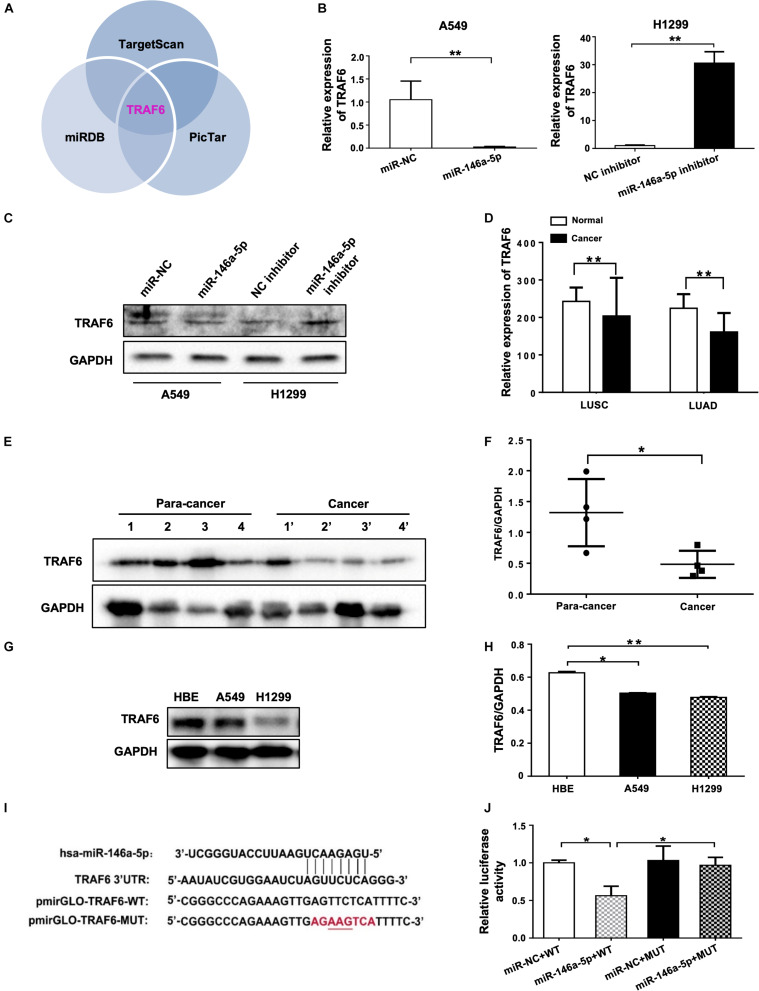
miR-146a-5p directly targets TRAF6 in NSCLC Cells. (A) TRAF6 is one of miR-146a-5p targets predicted by TargetScan, miRDB and PicTar databases. Expression of TRAF6 mRNA (B) and protein (C) in A549 cells or H1299 cells at 24 h transfection with miR-146a-5p mimic, or miR-146a-5p inhibitor respectively. (D) Expression of TRAF6 from TCGA, LUSC: lung squamous cell carcinoma, LUAD: lung adenocarcinoma. (E) Differential TRAF6 protein levels in NSCLC tissues and the paired adjacent normal tissues. (F) Quantitation of WB data as in (E). (G) TRAF6 levels in two NSCLC cell lines and HBE cell line. (H) Quantitation of WB data as in (G). (I) miR-146a-5p binding site within the 3’UTR of human TRAF6 mRNA predicted by TargetScan. Luciferase reporter construct only contains the 7 bp seed sequence and with the center 3 bp mutated in the mutant construct. (J) The relative luciferase activity in A549 cells co-transfected with miR-146a-5p mimic WT and MUT luciferase reporter (24 h post transfection).